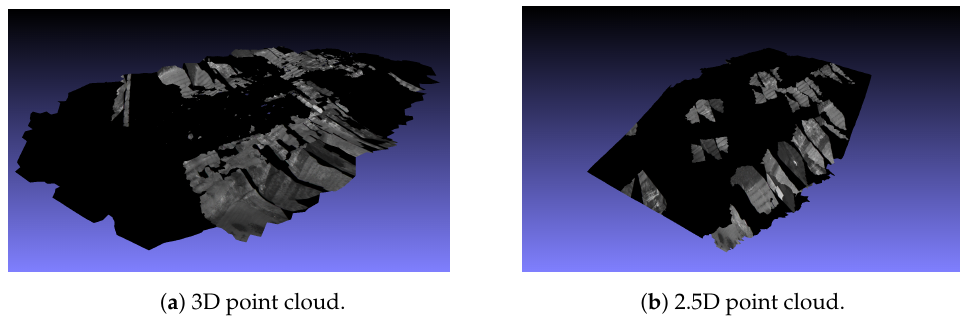
Figure 30. Multispectral point cloud models generated from the processing of imagery obtained from MicaSense